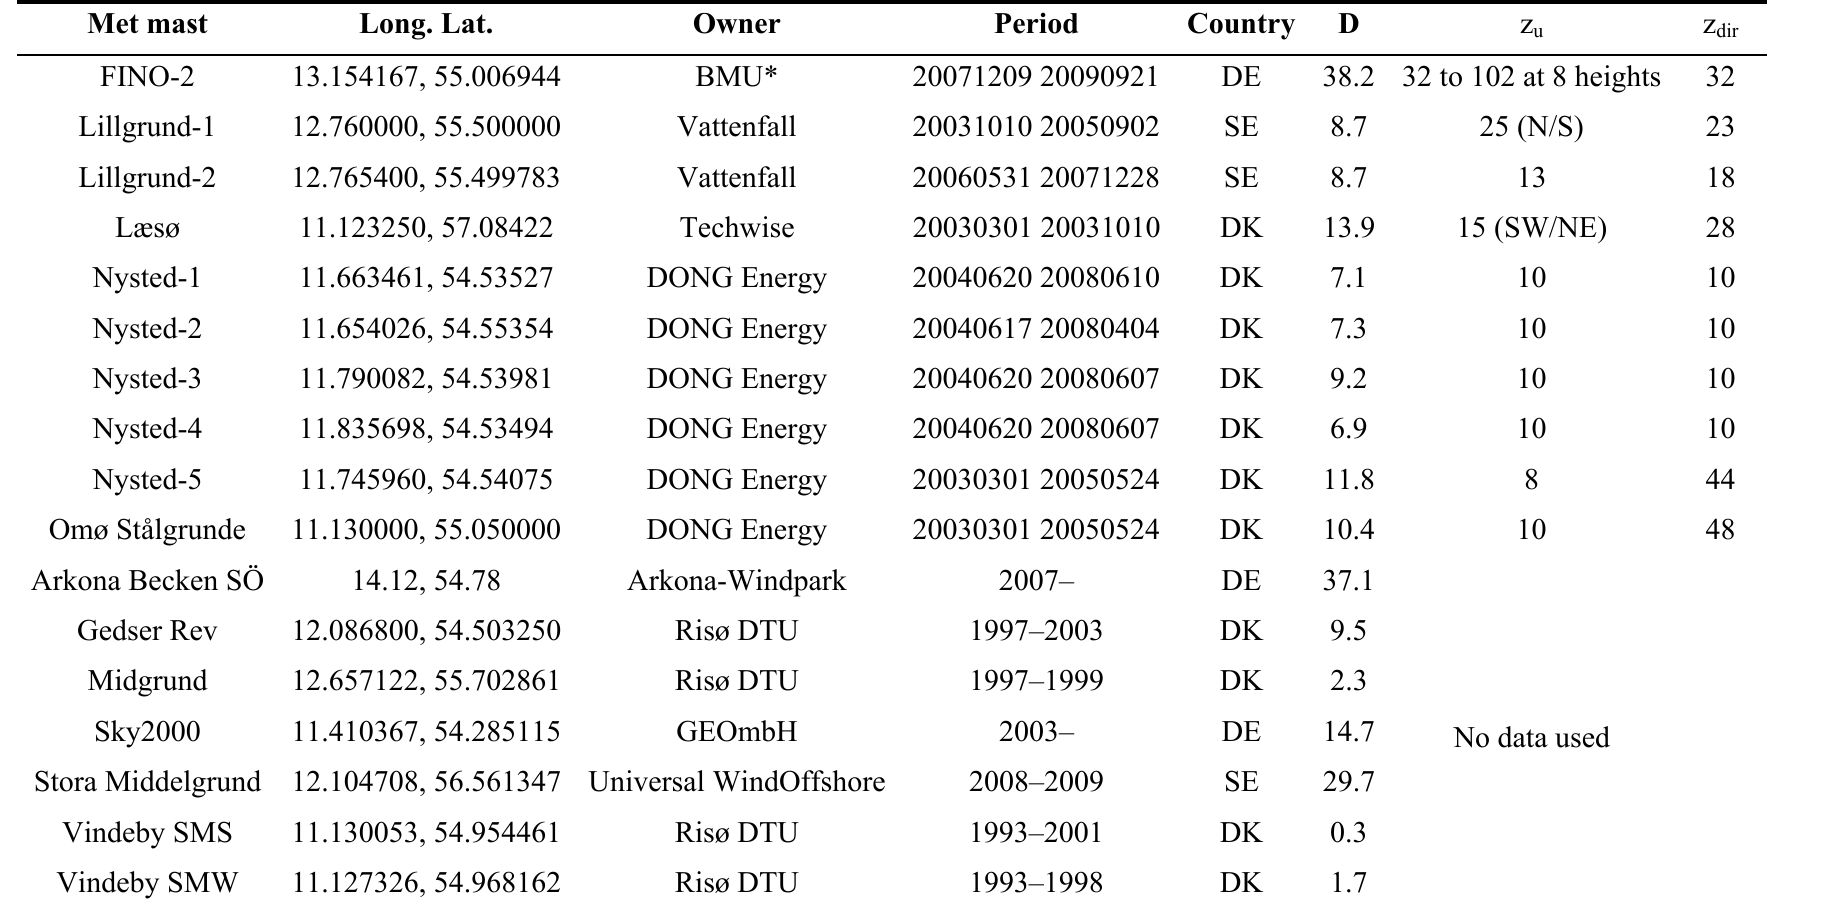
Table 2. Longitude (long.) and latitude (lat.) for 17 met-masts in the study area: In situ data from the top ten masts are used in the comparison study with indication of the data periods used and the observational heights for wind speed (z used. The distance (D in km) to nearest land is given for all